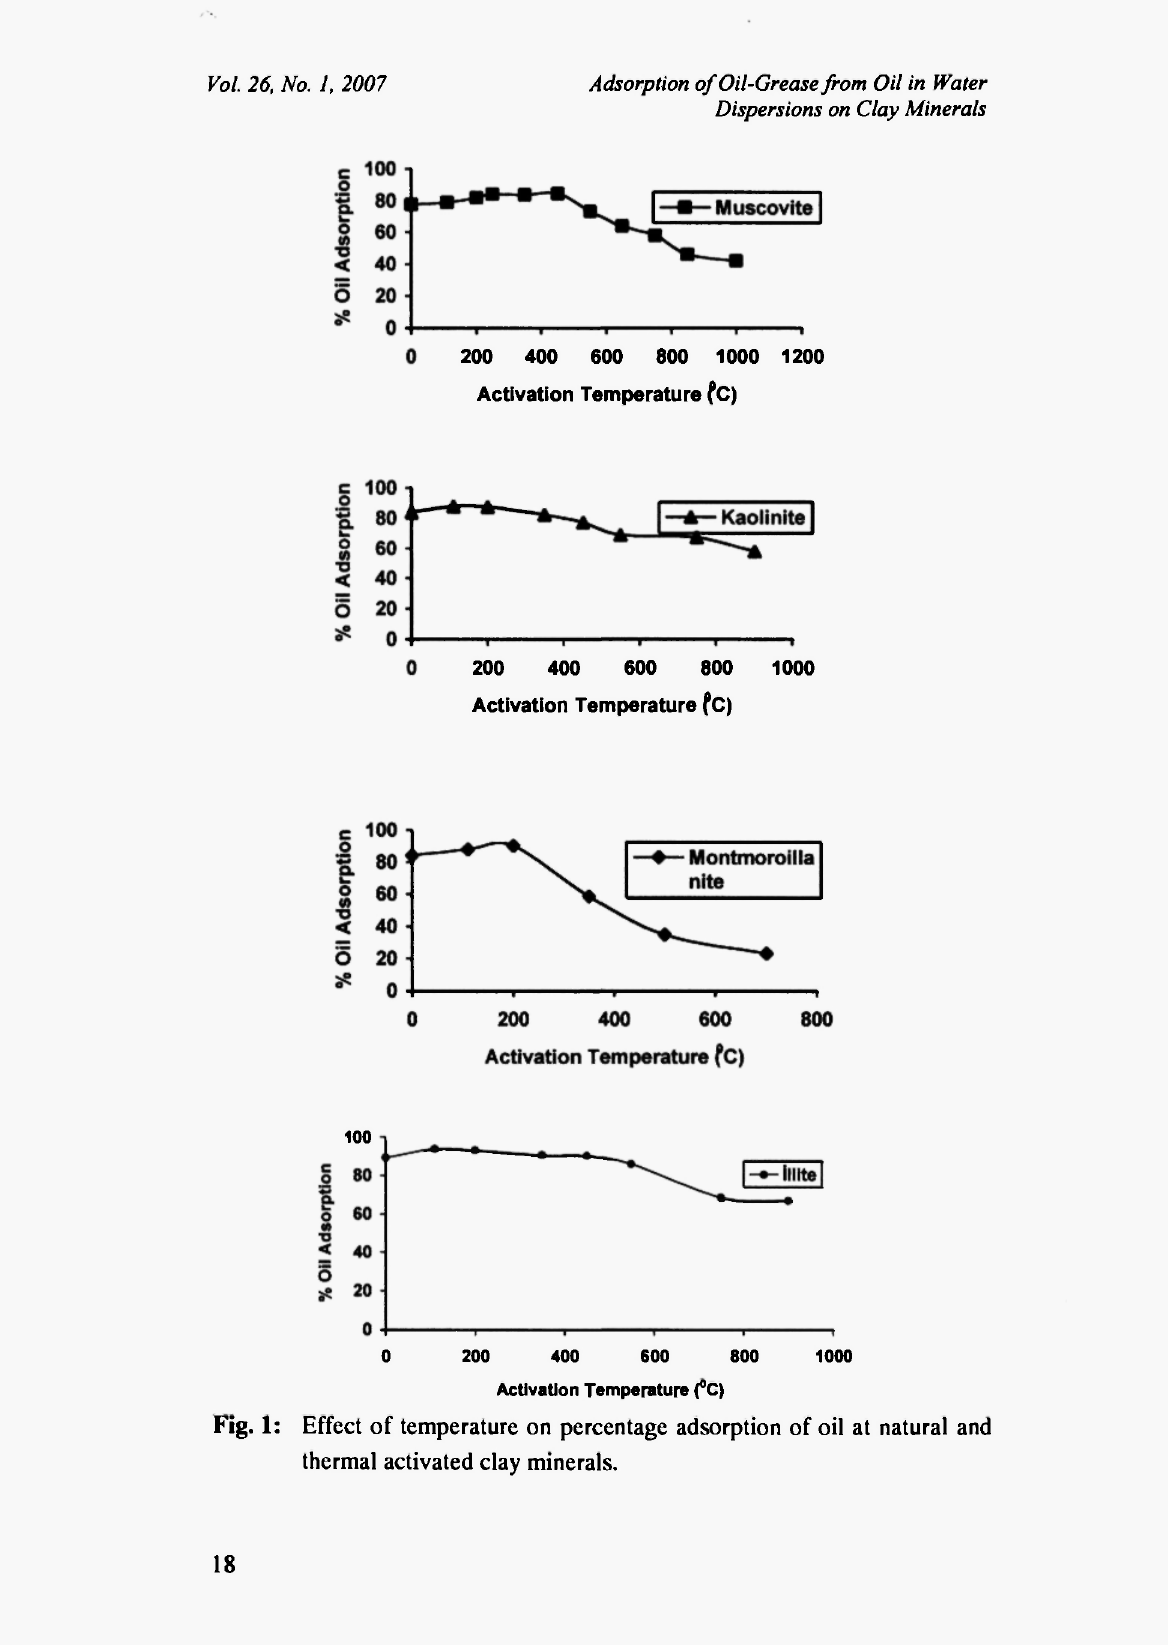
Fig. I: Effect of temperature on percentage adsorption of oil at natural and thermal activated clay